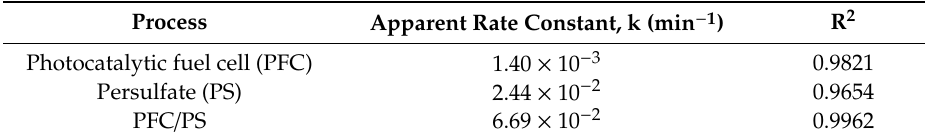
Table 1. The kinetic parameters of norfloxacin (NOR) degradation in different systems.